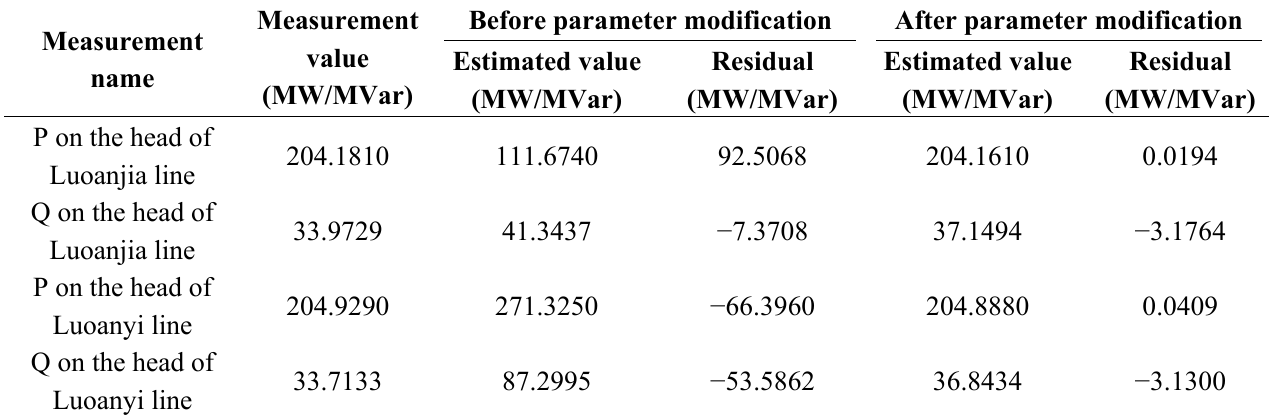
Table 4. Relative measurement residuals before and after modifying X of Luoanjia line. Measurement